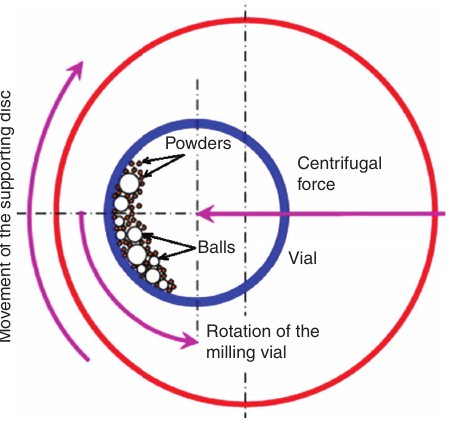
Figure 1 Schematic illustration of the MA